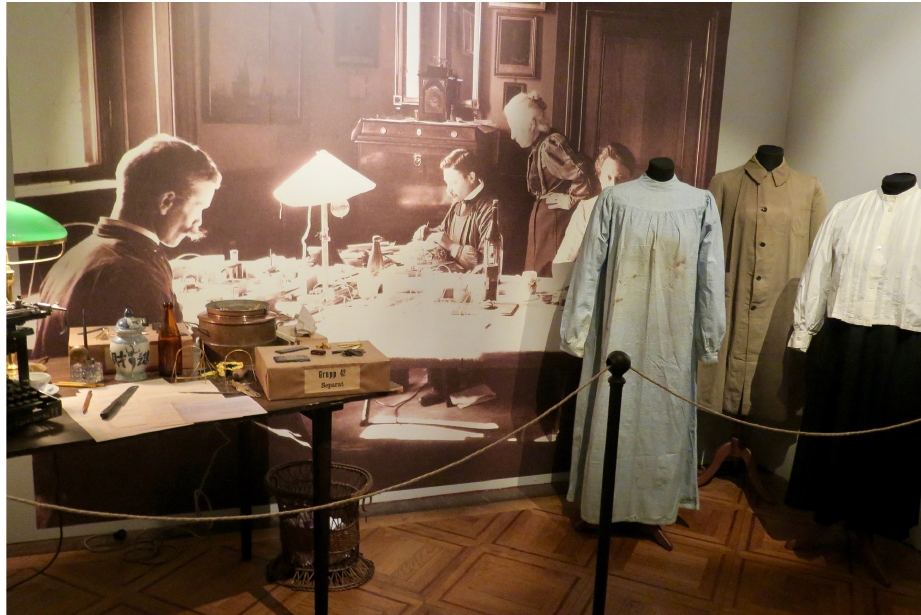
Figure 2: From the exhibition För all framtid , where archival materials were mobilized and put on display. (Photo: Lizette